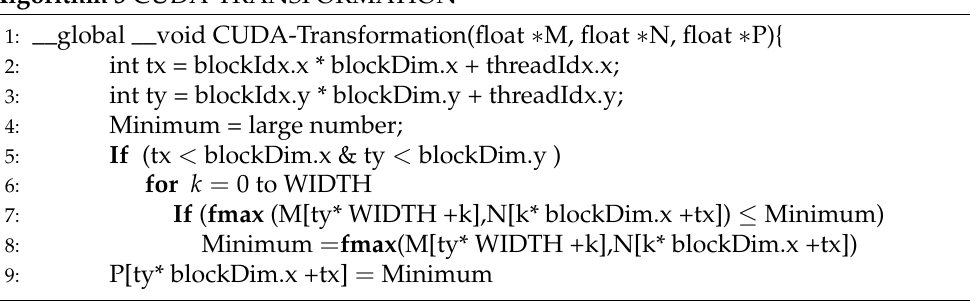
Algorithm 3 CUDA-TRANSFORMATION